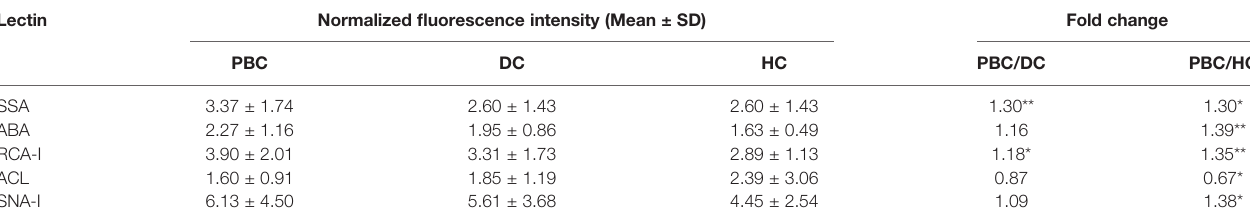
TABLE 2 | Difference of speci fi c binding between IgG and lectin in PBC, DC, and HC groups.